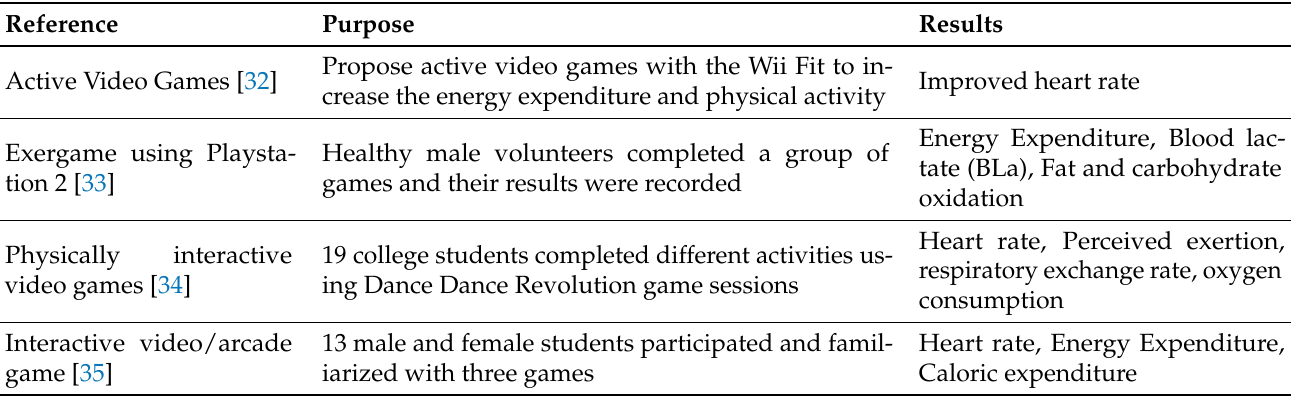
Table 1. Summary of different studies supporting the use of serious games for